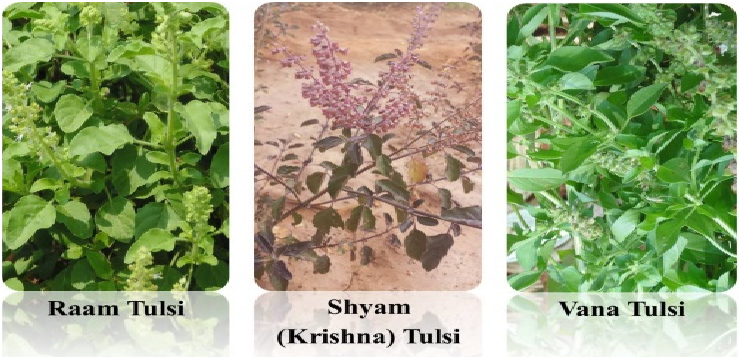
Figure 1. Raam, Shyam and Vana Tulsi grown in Bangalore, India ( pictures by S.K.Bhamra ).